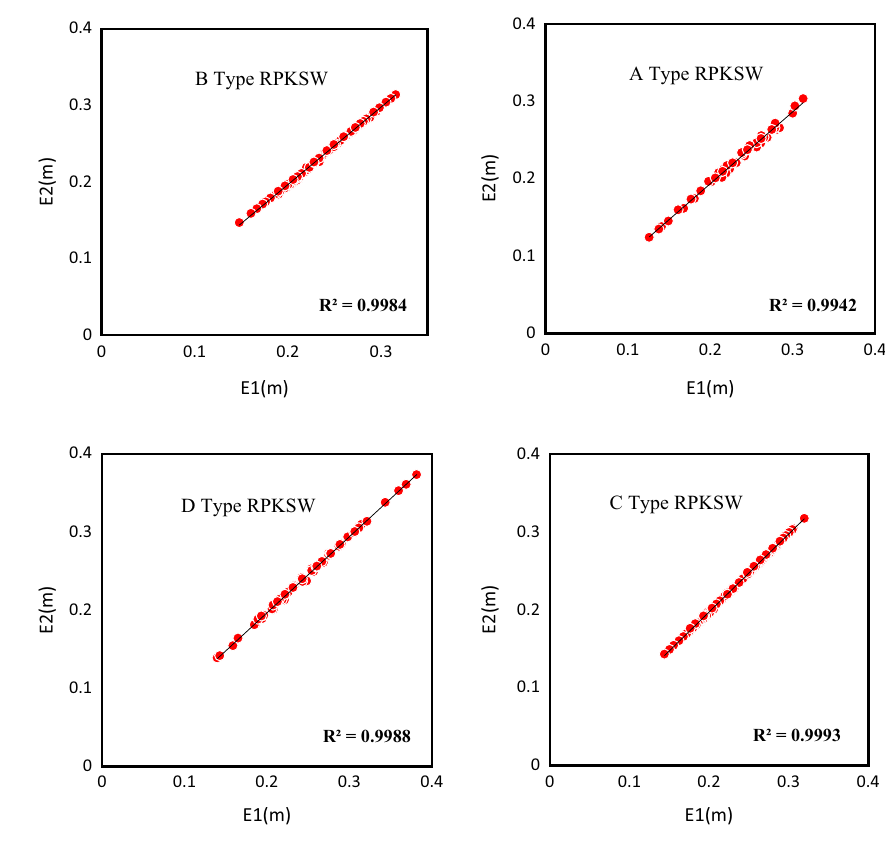
Fig. 6 Variations of specific energy at the first and second edges of the weir